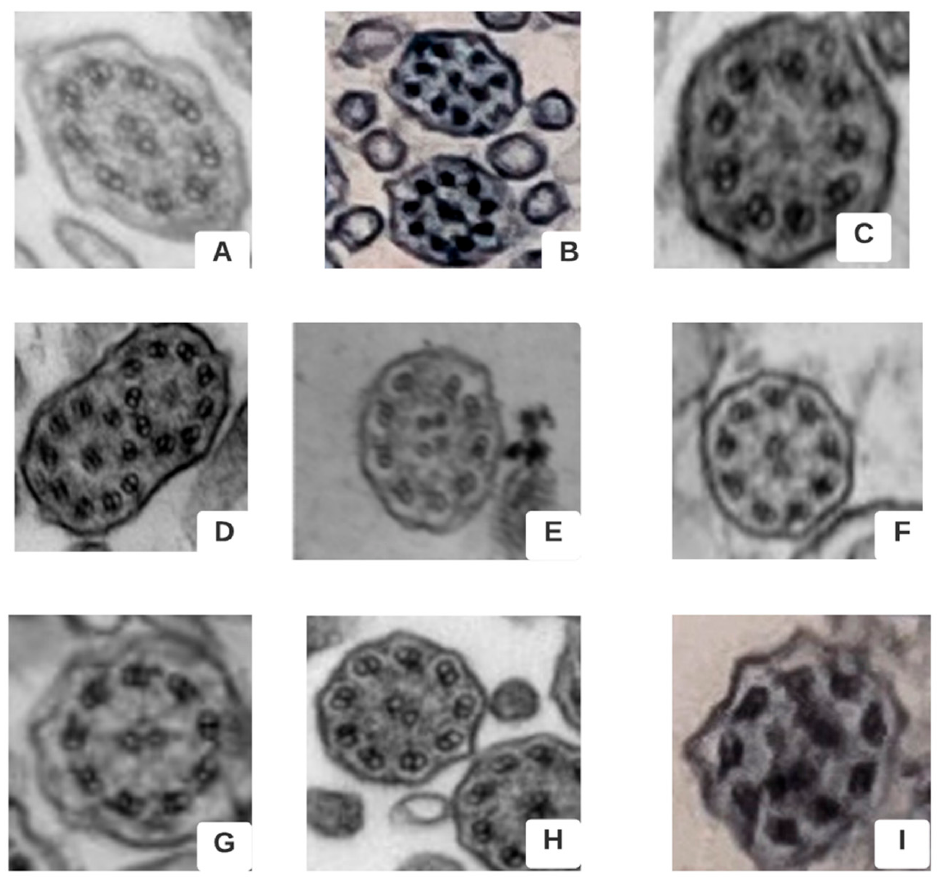
Figure 2. Transmission electron microscopy (TEM) findings as described in the “Better Experimental Approaches to Treat Primary Ciliary Dyskinesia” criteria (BEAT-PCD TEM criteria) from ERS [21] and TEM images of nasal brushing of patients from the study. ( A ) Normal ultrastructure (Case. 8). ( B ) TEM showing absence of inner and outer dynein arm combined with microtubular disorganization (Case 13). ( C , D ) Absent inner dynein and outer dynein arm and compound cilia (Case 15). ( E ) Two pairs of central microtubules (Case 29). ( F ) Absent inner dynein arm (Case 19). ( G ) Absent inner dynein arm (Case 21). ( H ) Absent inner dynein and outer dynein arm (Case 27). ( I ) Absence of inner dynein arm combined with microtubular disorganization and central complex defect (Case